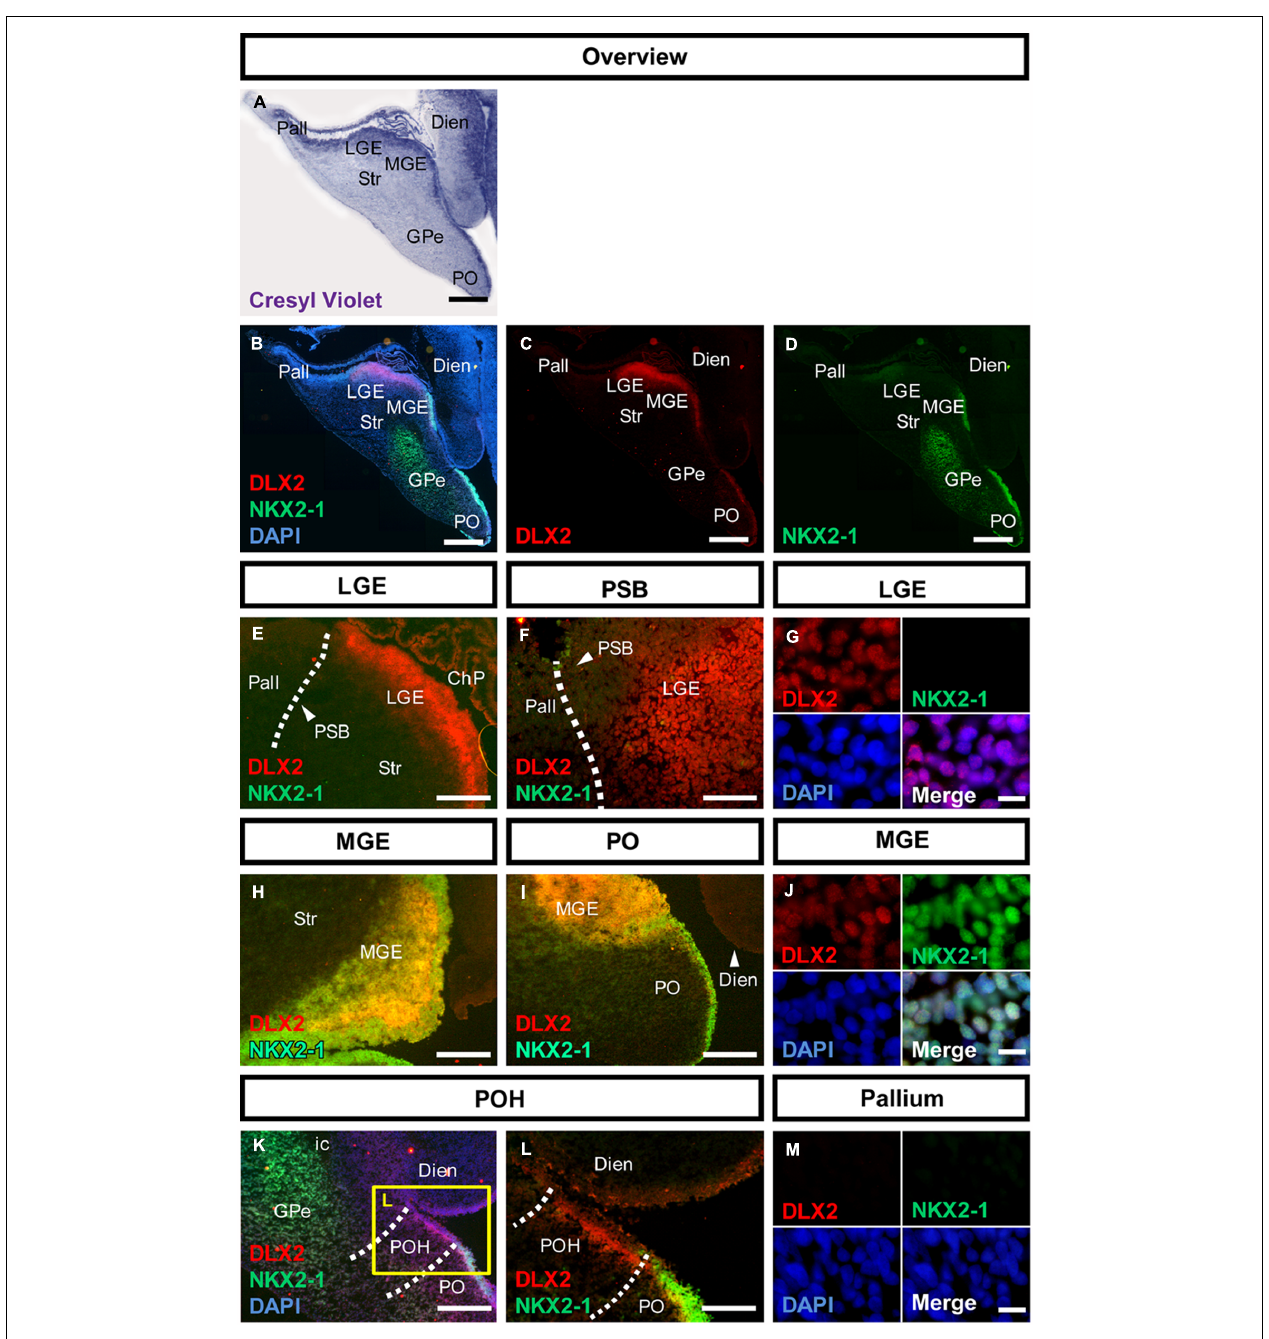
FIGURE 1 | Molecular characterization of the human subpallium. (A) Photomicrographs of cresyl-violet coronal human subpallial sections. (B–D) Photomicrographs of sections stained against DLX2 (red) and NKX2-1 (green) and DAPI (blue). (E,F) DLX2-positive cells were detected in the LGE and end abruptly at the PSB. (G) Verification of nuclear DLX2 signal in the LGE and absence of NKX2-1. (H–J) DLX2/NKX2-1 co-expressing cells were detected in MGE and PO. (K,L) Cells within the boundary between subpallium and hypothalamus express DLX2 and lack NKX2-1. (M) Neither DLX2-positive nor NKX2-1 positive cells were detected in the pallium. Abbreviations: CGE, caudal ganglionic eminence; ChP, choroid plexus; DARPP32, dopamine- and cAMP-regulated phosphoprotein, 32 kDa; Dien, diencephalon; dLGE, dorsal part of the lateral ganglionic eminence;